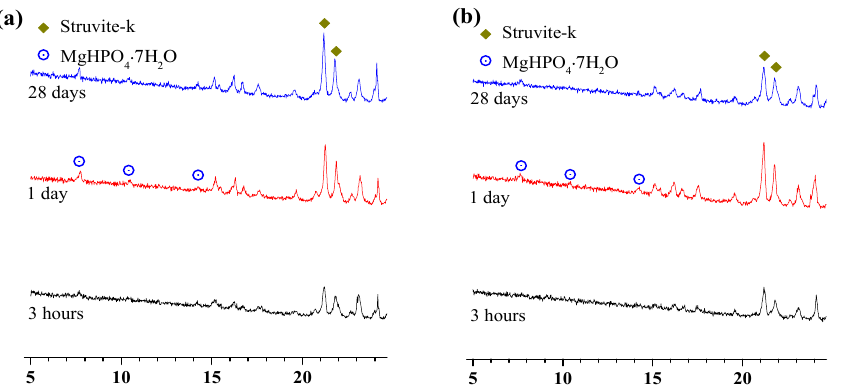
Figure 9. XRD diffraction patterns of MKPC at a w/c ratio of 0.2 at different stages of hydration: ( a ) 1% sodium alginate; ( b ) 2% sodium alginate.